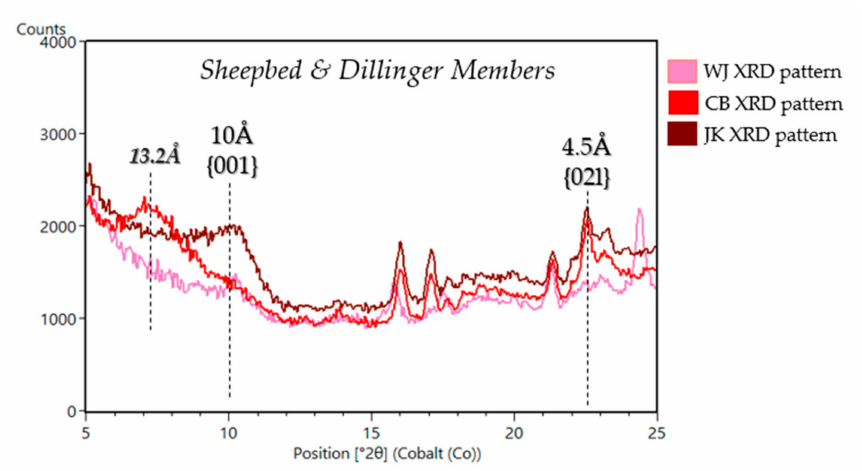
Figure 10. CheMin XRD patterns from 5 ◦ to 25 ◦ 2 θ of drill samples from the Bradbury group. The d(001) and d(02l) peaks are denoted by dashed black lines. A pronounced 10 Å d(001) peak is seen in the JK pattern and an uncharacteristic 13.2 Å peak is observed in the CB pattern, signifying potential partial chloritization (i.e., pillaring) of the smectite